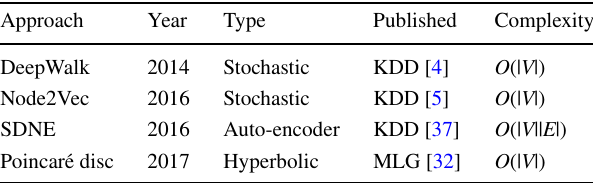
Fig. 1 Distribution of topological feature values from the cit-HepTh dataset in log scale: a total vertex degree distribution, b distribution of com- plete triangles for each vertex, c eigenvector centrality distribution and d betweenness centrality score Table 1 Graph embedding approaches being compared